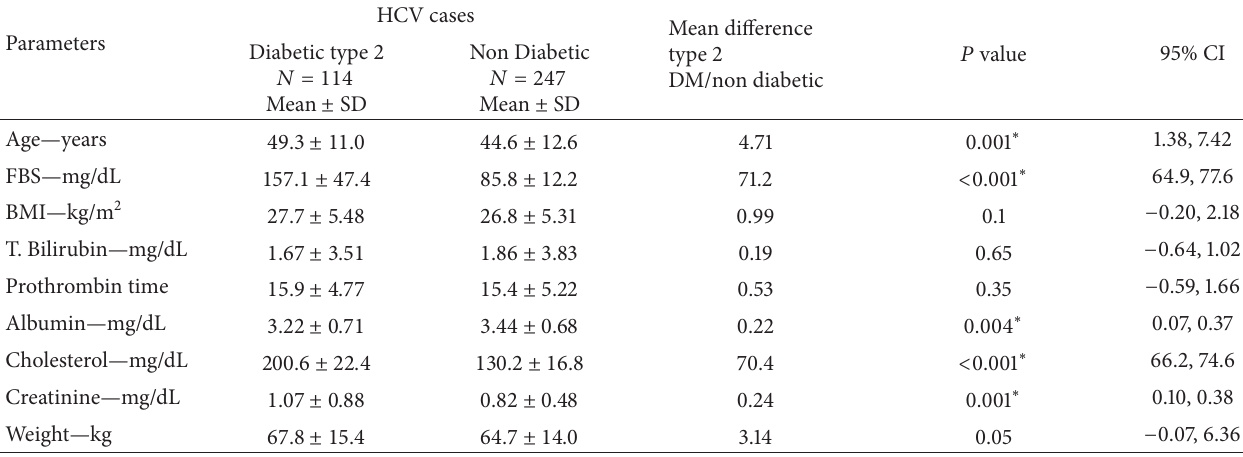
Table 2: Unpaired t -test for the mean differences between diabetic and nondiabetic HCV seropositive patients.